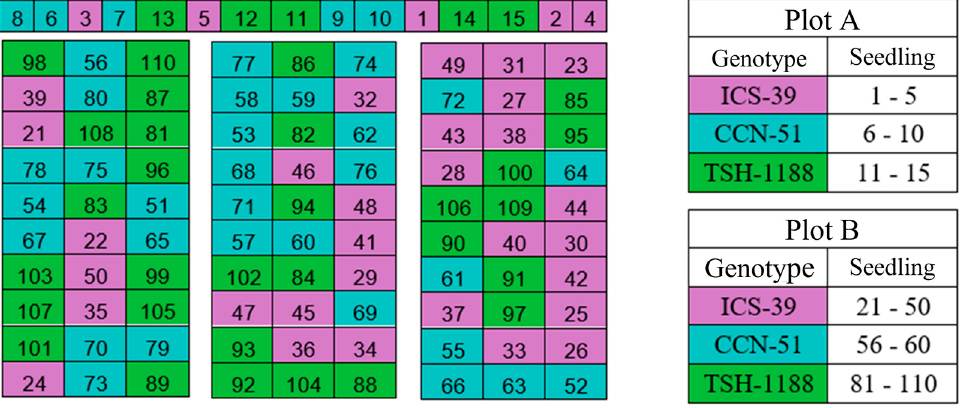
Figure 1. Randomized scheme of pots used for seedling treatment with different doses of zeolite